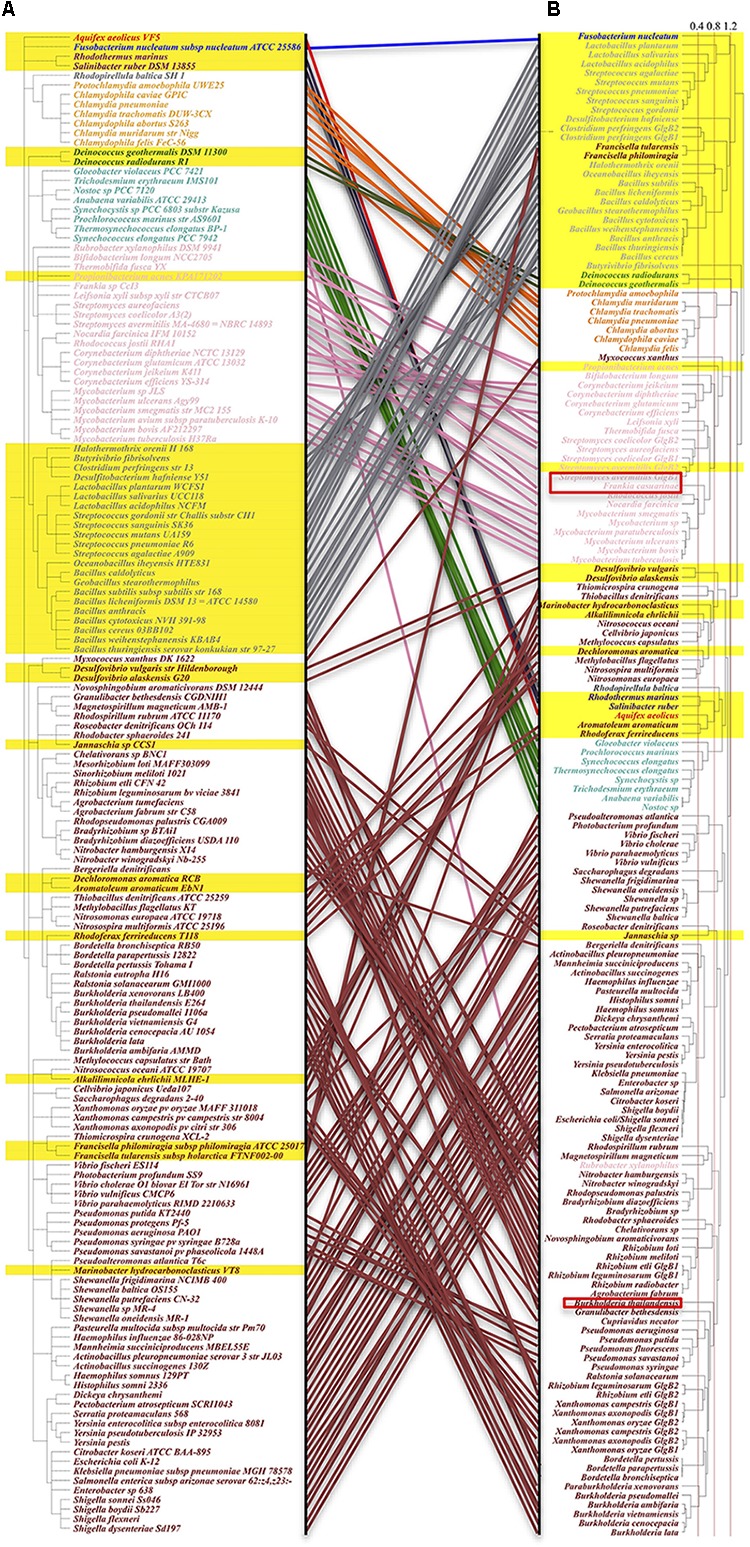
Comparison of taxonomy-based and maximum-likelihood calculated phylogenetic trees. Species orders in the phylogenetic tree are not meaningful, hence not considered in the analysis. Left: (A) GBEs in taxonomy-based phylogenetic tree show clustered distribution patterns. One hundred and fifty-seven species belonging to 10 phyla are analyzed, which are (from top to bottom): Aquificae (red), Fusobacteria (blue), Bacteroidetes (brown), Planctomycetes (dim gray), Chlamydiae (orange), Deinococcus-Thermus (Green), Cyanobacteria (light green), Actinobacteria (pink), Firmicutes (gray), and Proteobacteria (maroon). All Type 2 GBEs are highlighted within the range of a yellow strip. Proteobacteria and Actinobacteria are dominated with Type 1 GBE while Chlamydiae and Cyanobacteria mainly have Type 1 GBE. GBE Type 2 is identified mainly in Firmicutes and distributed sporadically in other phyla. Right: (B) Maximum-likelihood phylogenetic tree with 1,000 bootstrapping. Taxonomy- and sequence-based results are comparatively consistent at phylum level. Several GBEs from species such as Rubrobacter xylanophilus and Francisella tularensis show obviously evolutionary change that may be due to horizontal gene transfer or selective stresses for paralogs. Potential Type 3 GBEs in bacteria Frankia casuarinae, Burkholderia thailandensis, Streptomyces avermitilis are marked in the tree with red rectangle frameworks.